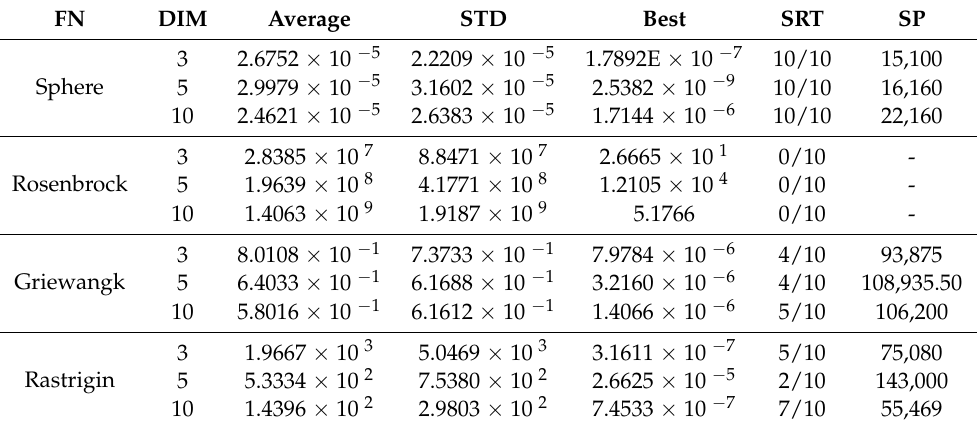
Table 6. Simulation results of the original